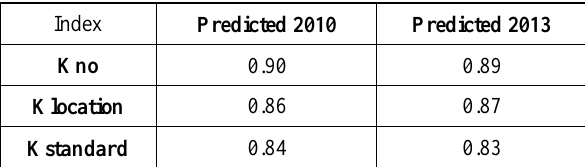
Table 5. Validation between predicted and actual images of 2010,